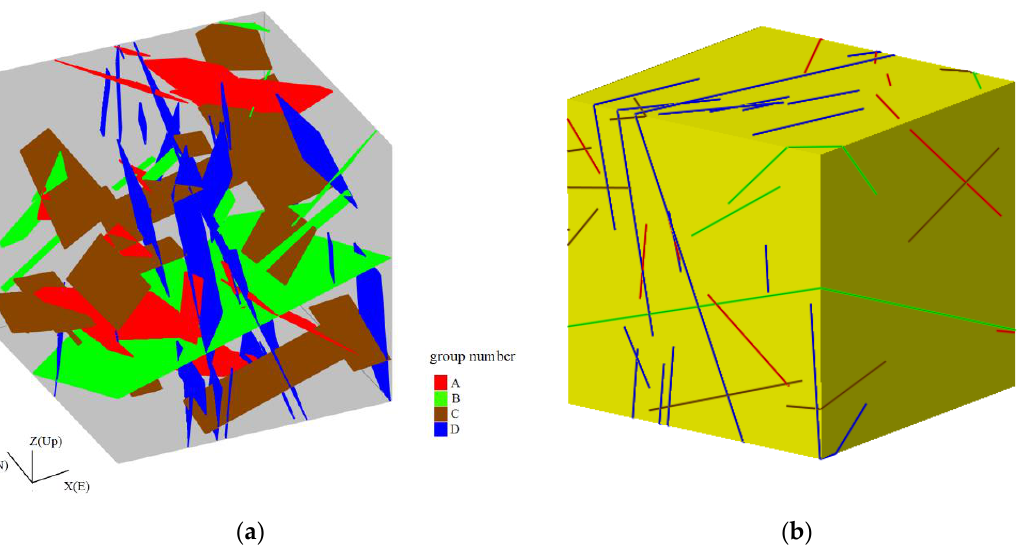
Figure 4. 3D DFN model. ( a ) Spatial cross-cutting relationship of each group of fractures; ( b ) spatial cross-cutting relationship between fractures and the boundary of the study domain.